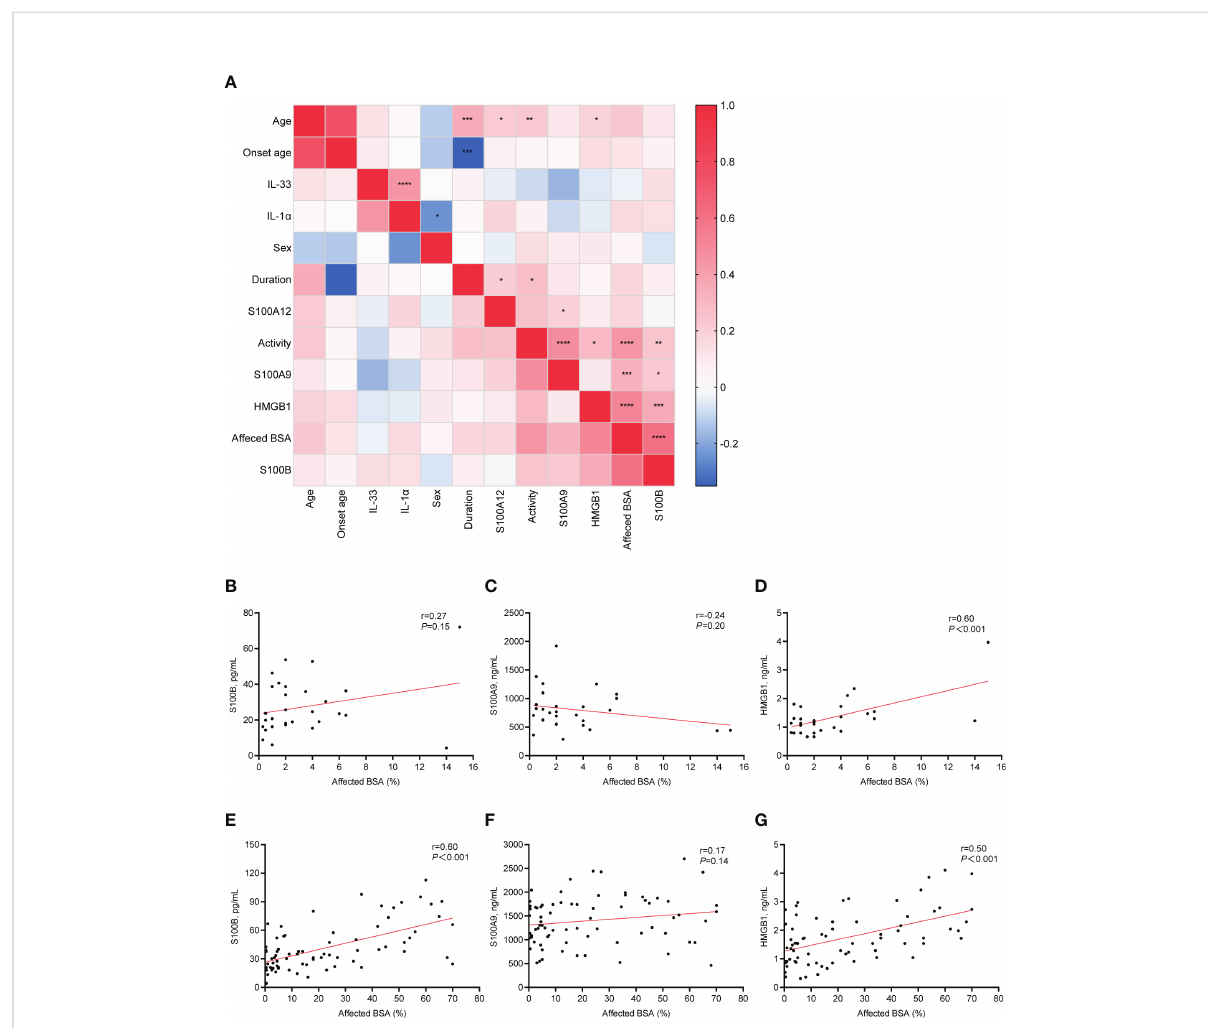
FIGURE 4 Correlation between clinical characteristics and serum alarmins. (A) , The correlation heatmap of clinical characteristics and serum alarmins by using Pearson correlations. (B – D) , Correlation changes in serum level of S100B, S100A9, and HMGB1 with changes in the affected BSA (%) of patients with stable vitiligo. (E – G) , Correlation changes in serum level of S100B, S100A9, and HMGB1 with changes in the affected BSA (%) of patients with active vitiligo. P values were calculated by Pearson correlation. * P < 0.05, ** P < 0.01, *** P < 0.001, **** P <